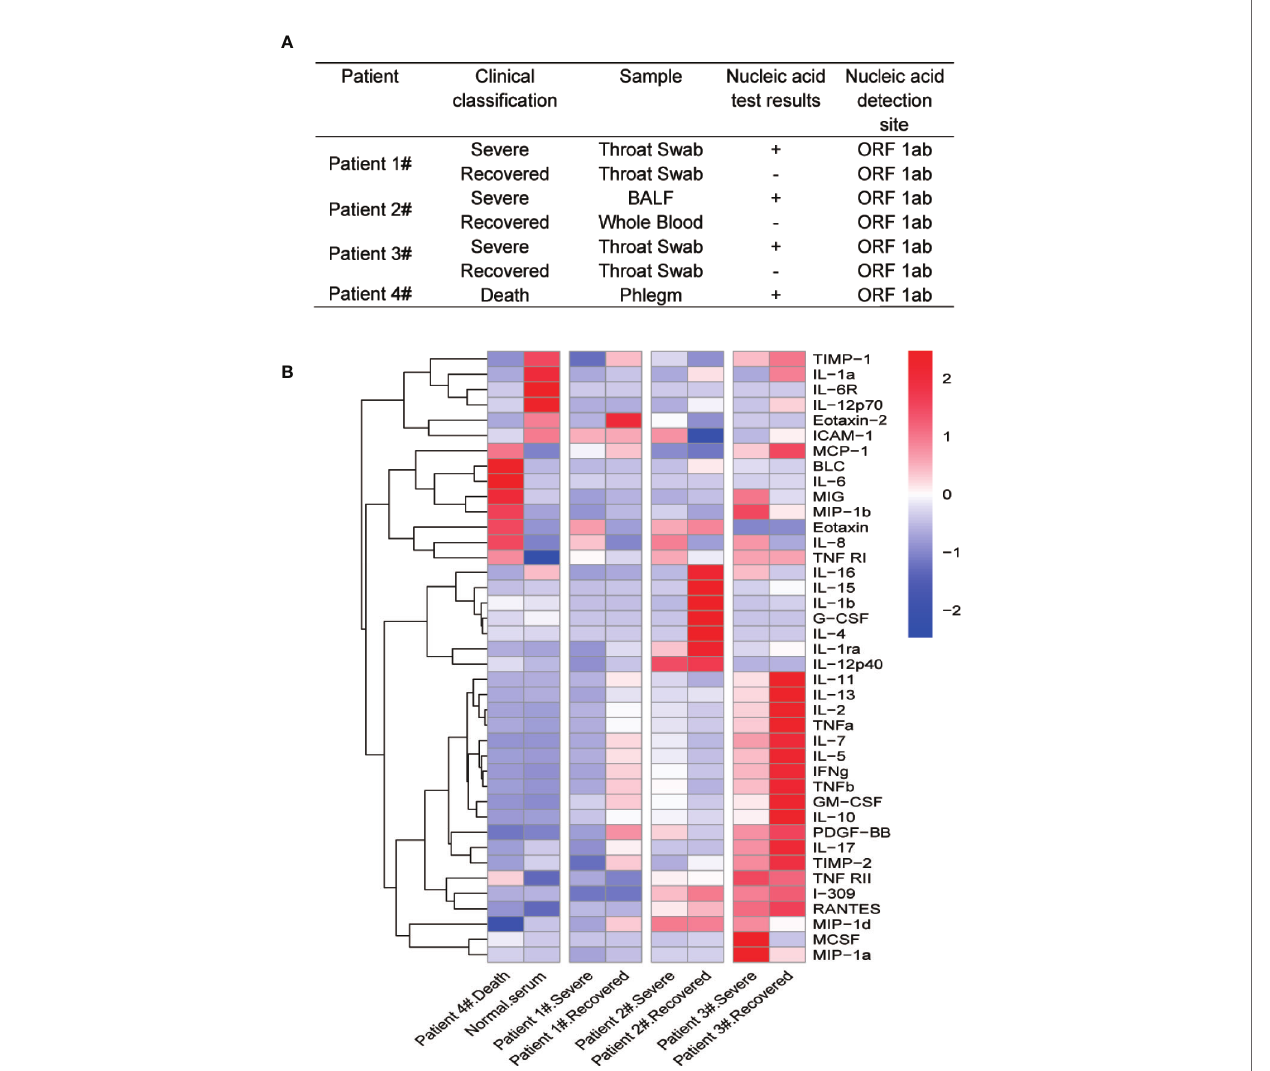
FIGURE 1 | Multiple cytokine pro fi le from different clinical outcomes of SARS-CoV-2 infected patients. (A) Clinical outcomes and nucleic acid test results of four SARS-CoV-2 infected patients. The patients were divided into two groups by clinical outcomes: severe and recovered. Patient 4# died in the hospital. (B) Heatmap of cytokines in sera from COVID-19 patients during different clinical stages. Because of the death, we did not get recovered serum from patient 4#. We then added normal serum as a control. Cytokine levels were detected using Quantibody ® Human In fl ammation